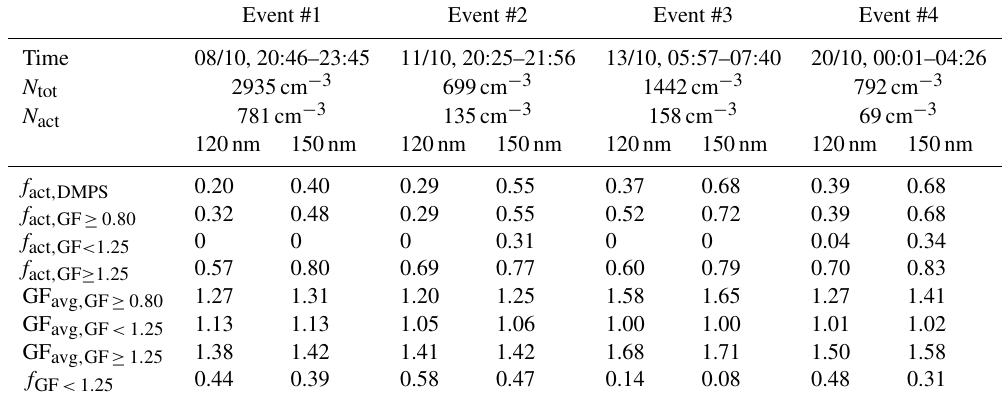
Table 1. Overview of the four cloud events observed during the measurement campaign. Given are the total particle and cloud droplet number concentrations as well as the hygroscopicity-dependent activation efficiencies and growth factors of 120 and 150nm particles. The number fraction of less hygroscopic particles is denoted by f GF < 1 . 25